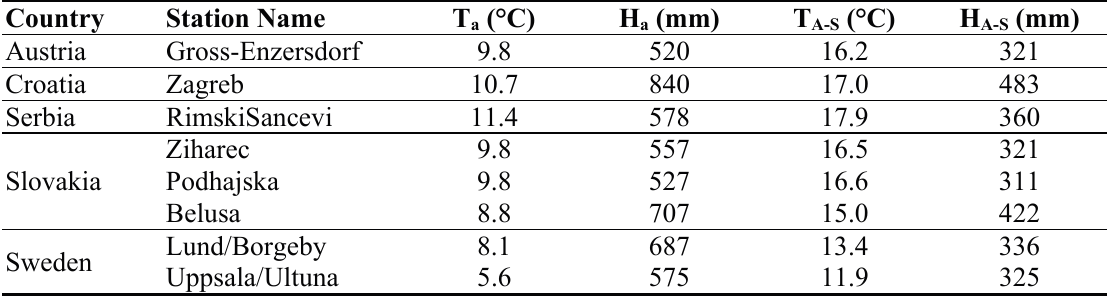
Table 2. Climate characteristics of the selected locations for 1971–2000 (T a = mean annual temperature, H a = annual precipitation sum, T A-S =April–September mean temperature, and H A-S = April–September precipitation